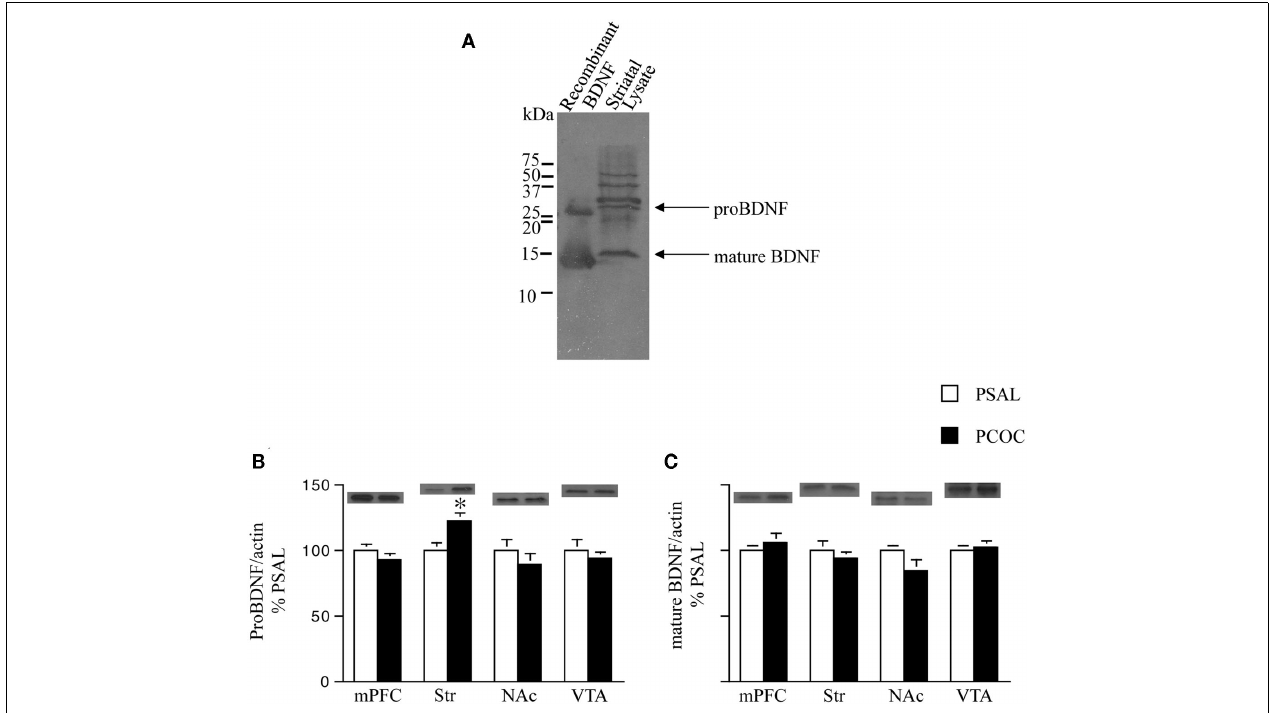
ventral tegmental area (VTA) of adult mice prenatally treated with saline (PSAL) or cocaine (PCOC). Protein levels were normalized to actin. Striatum of PCOC mice contained significantly higher amounts of pro-BDNF (B) compared to PSAL mice (* p < 0.05) with no difference in levels of mature BDNF (C) . All other regions showed no difference in the levels of pro- or mature BDNF. Error bars represent the mean ± SEM. N = 4–6 mice/group.